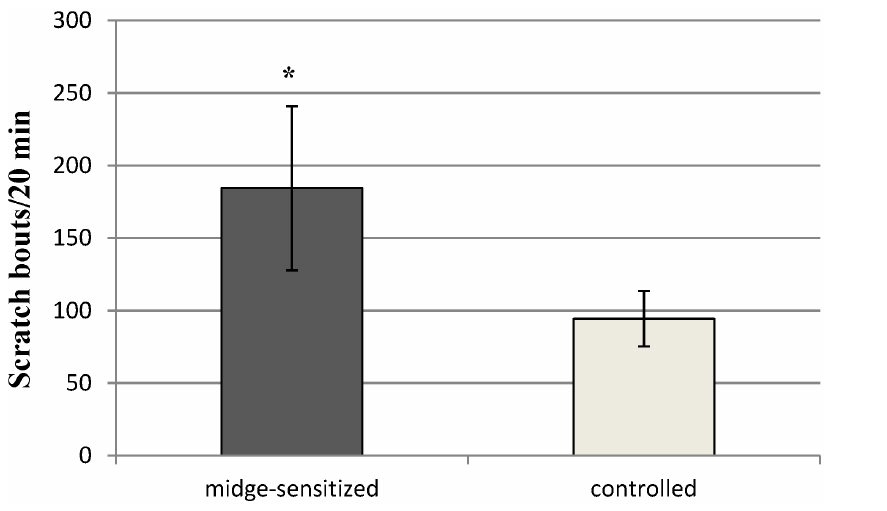
Figure 3. Counts of scratching bouts from midge-sensitized or controlled mice induced by intra-dermal injection of midge extract. The scratching behaviour was videotaped for 1 h and data represent the number of scratches for 20 minutes. Results were mean 6 SEM of nine mice from each group. * p , 0.05, by Mann-Whitney U test.